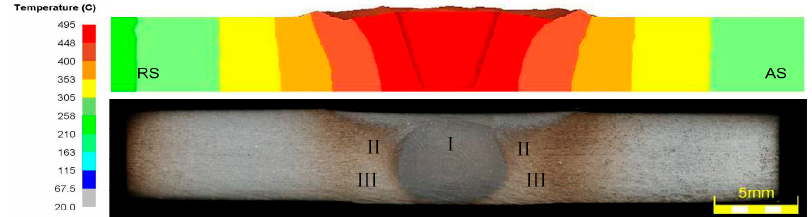
Figure 19. Cross-sectional comparison of the joints.